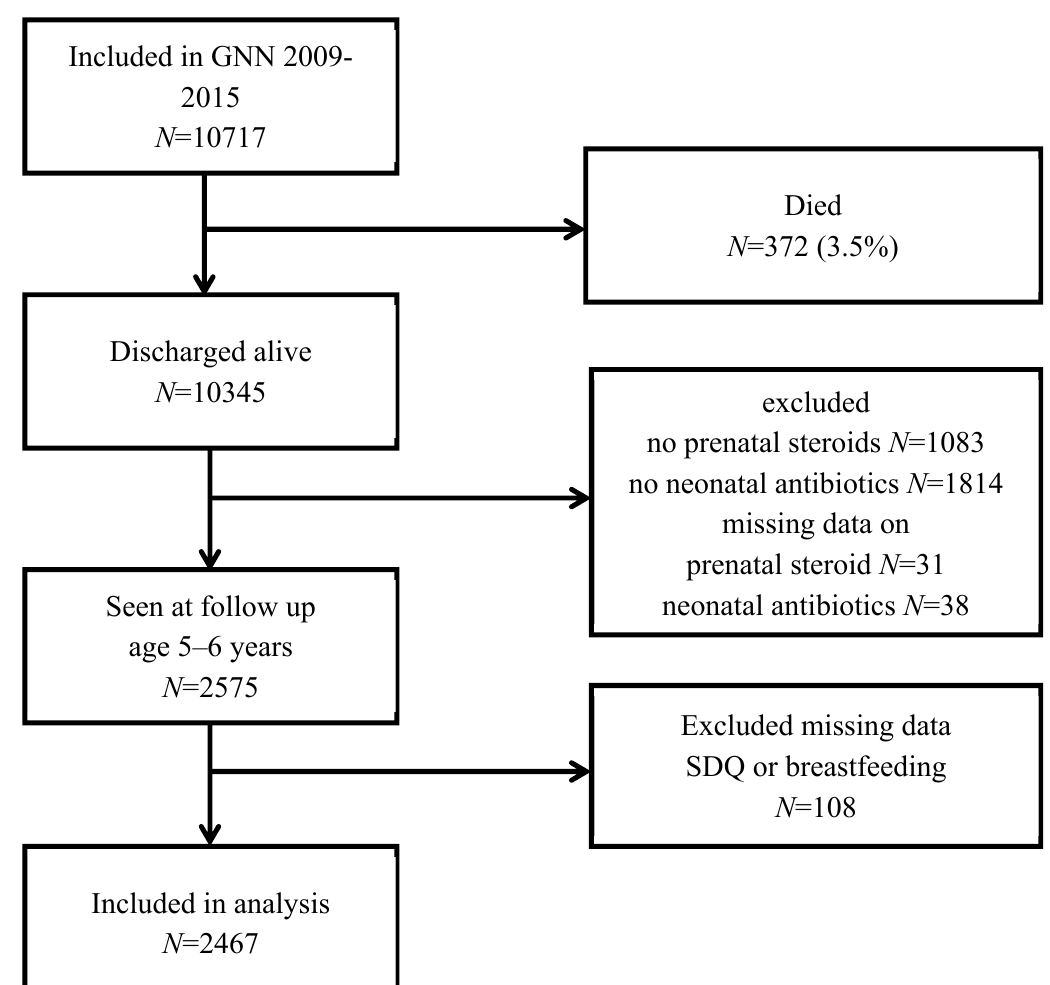
Figure A1. Flow chart of study participation.